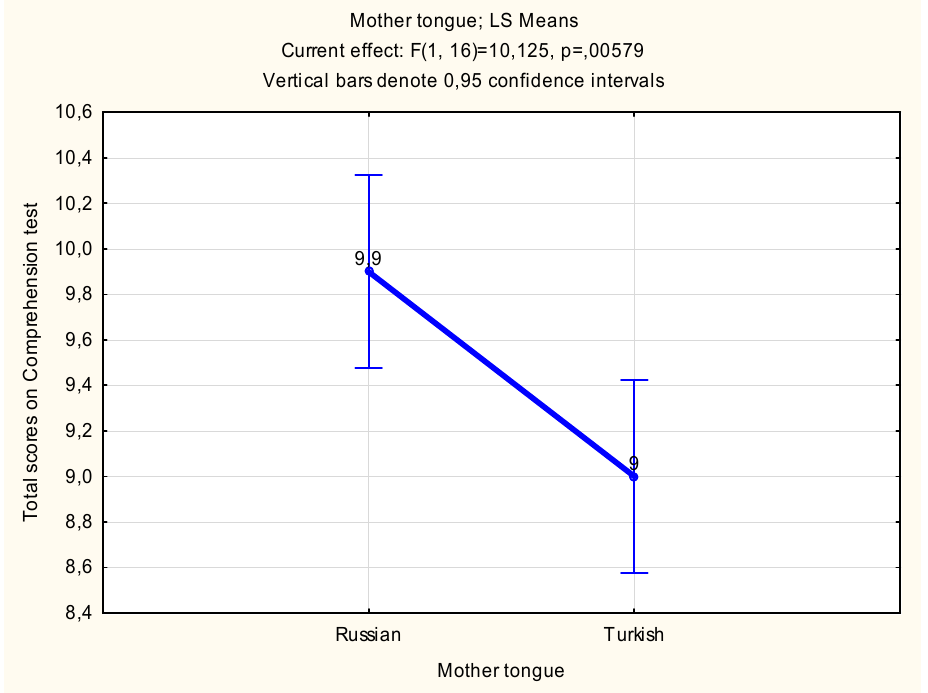
Fig. 1 – Total scores on Comprehension Test as a function of mother tongue